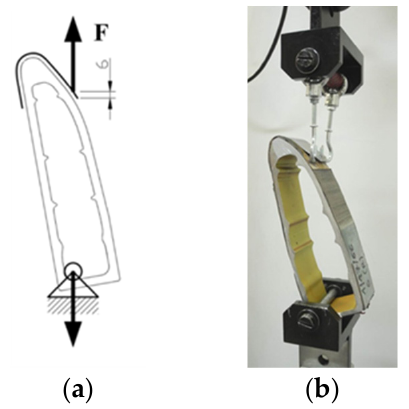
Figure 17. Comparative tests of the tearing off of the shield from the leading edge: ( a ) Scheme, ( b ) Sample on the test stand.